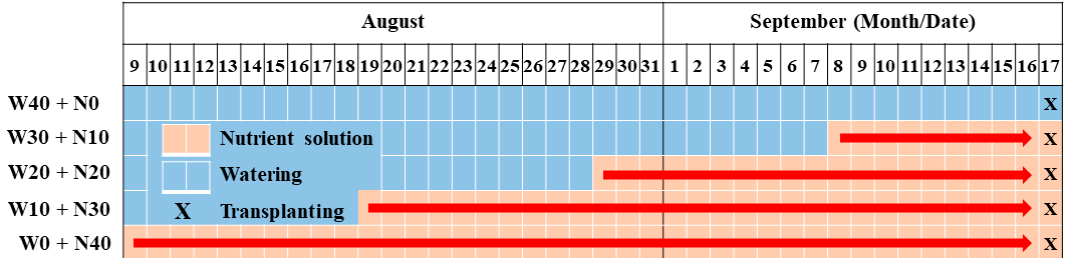
Figure 1. Nutrient solution resupply periods of runner plants in “Maehyang” strawberries. W40 +